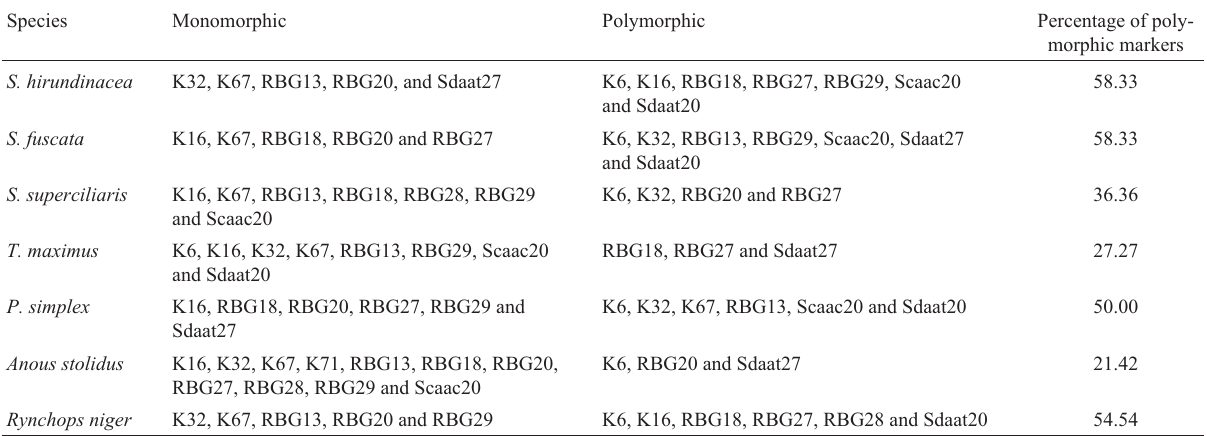
Table 2 - Summary of the monomorphic and polymorphic microsatellite loci and its proportion in each species.